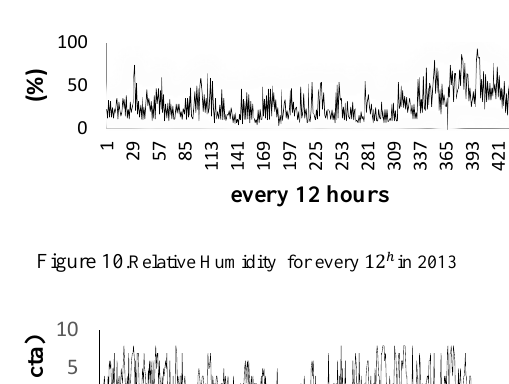
Figure 3 . Temperature for every 12 ℎ in 2012